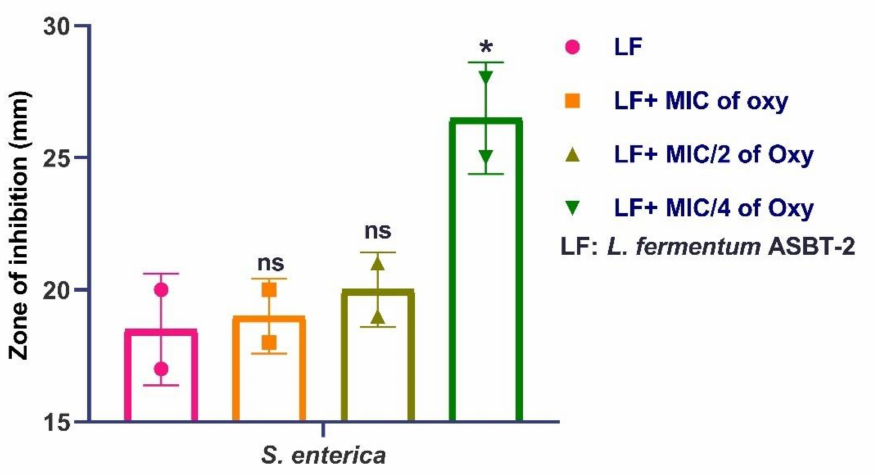
Figure 16. Antagonistic potential of L. fermentum ASBT-2 inhibiting S. enterica with different concen- trations of oxyresveratrol. * Significantly different ( p ≤ 0.05); ns: